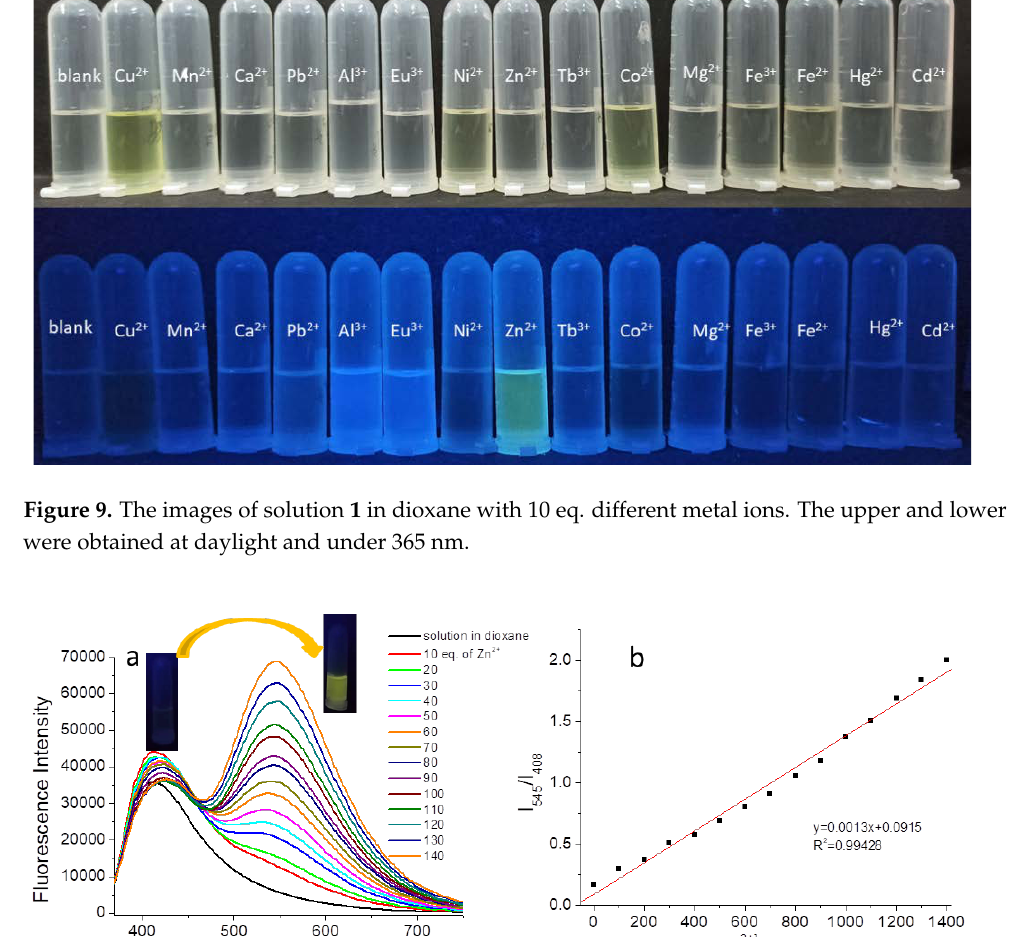
Figure 11. UV-vis absorption spectra change of solution 1 in 1,4-dioxane upon the titration of Zn 2+ . 400